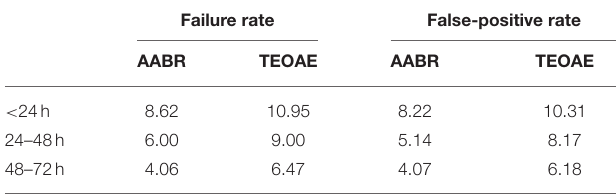
TABLE 5 | The failure rate and false-positive rate of the first screening at different